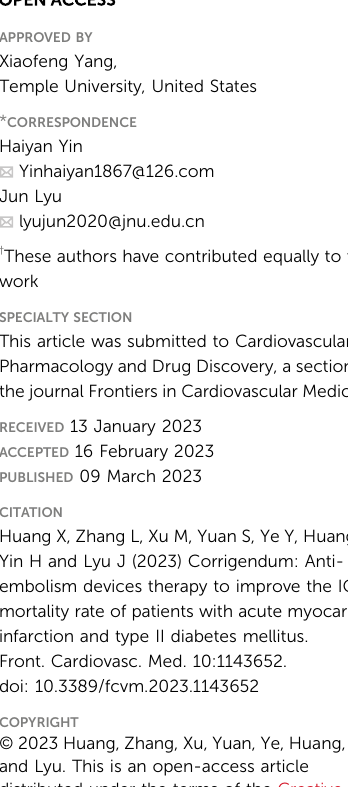
table. The corrected Table 2 appears below. Analysis of the associations between AE-device therapy and outcomes. HR, hazard ratio; CI, con fi dence interval. Models were derived from Cox proportional hazards regression models. Model I was not adjusted for